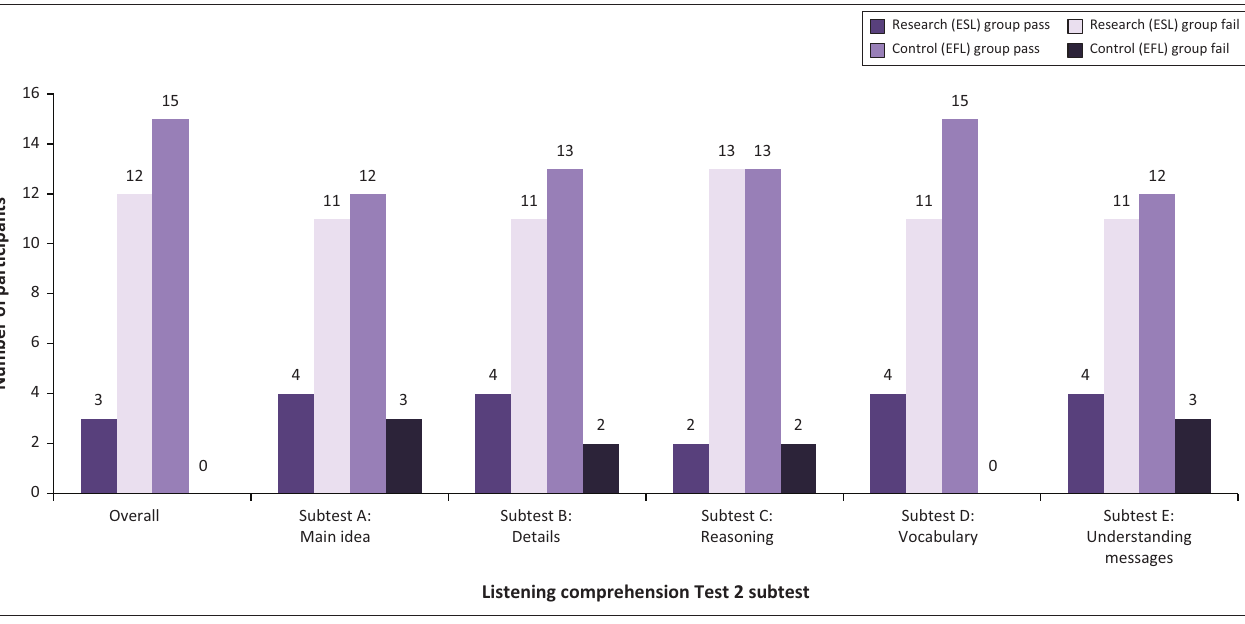
FIGURE 3: The number of participants in the English second language and English first language groups who passed or failed the various sections of the listening comprehension test 2. ESL, English second language; EFL, English first